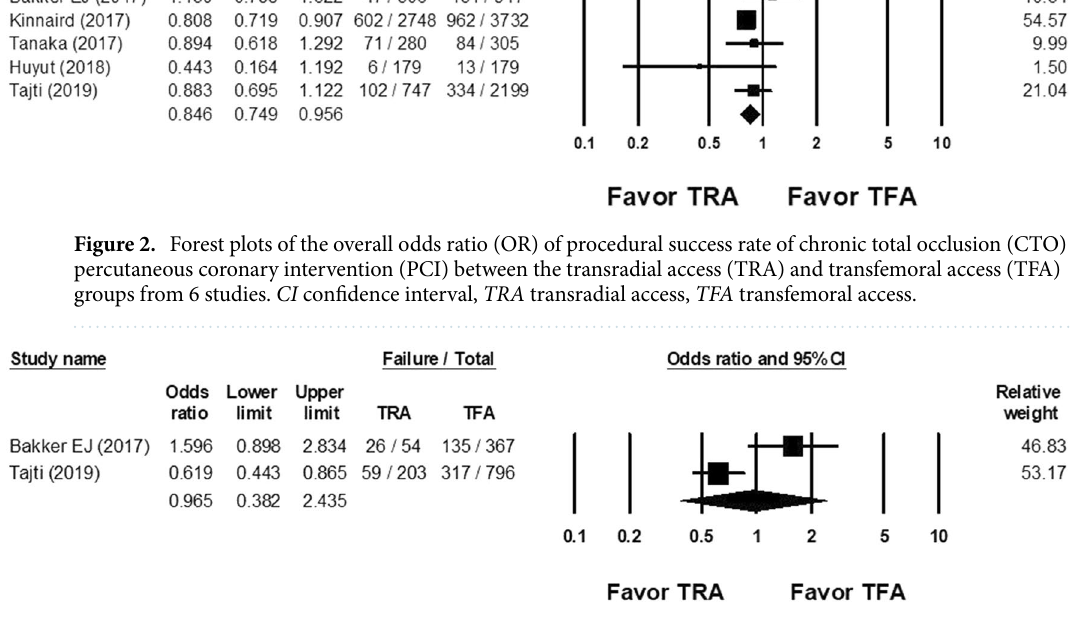
Figure 3. Forest plots of the OR of retrograde success rate of CTO PCI between the TRA and TFA groups from 2